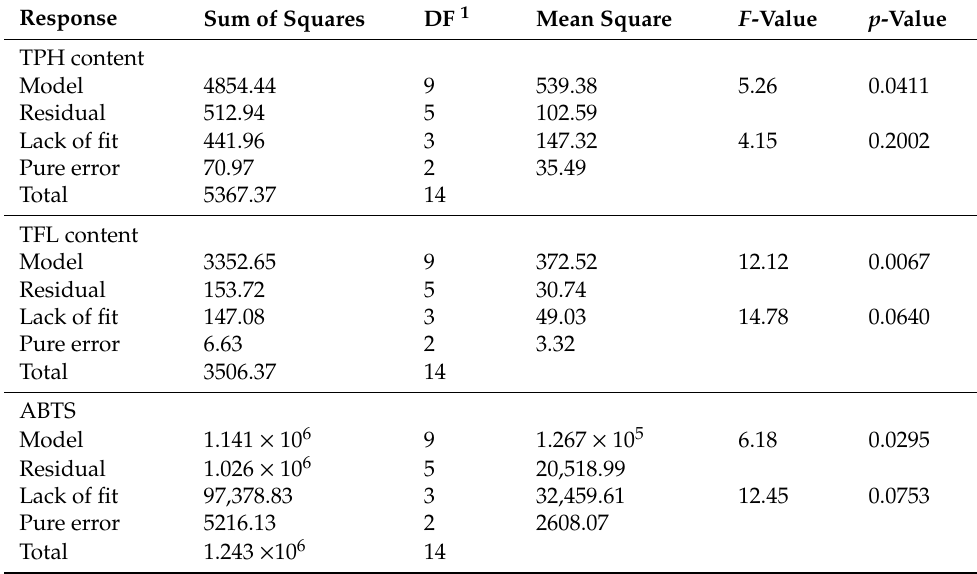
Table 4. Analysis of variance (ANOVA) of second-order polynomial models for TPH and TFL content and antioxidant activity in A. millefolium